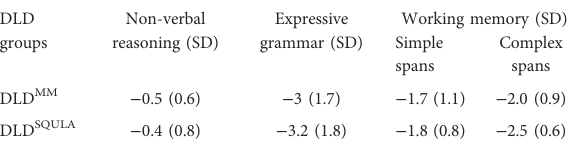
TABLE 2 Standardized assessments: non-verbal reasoning, expressive grammar and working memory. DLD